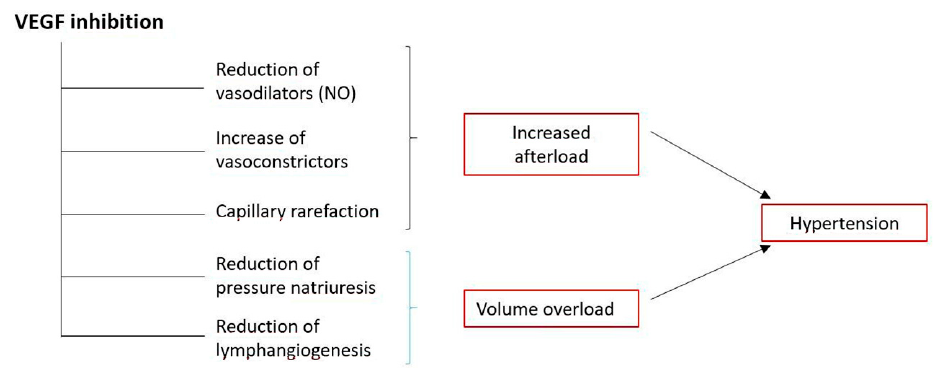
Figure 4. Proposed mechanisms in the genesis of hypertension by targeted anti-VEGF therapy. Modified from